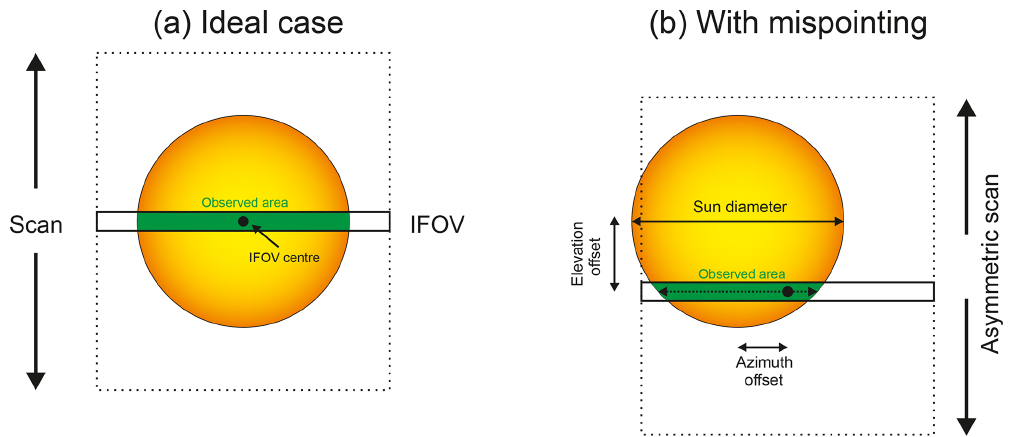
Figure 2. SCIAMACHY instantaneous field of view (IFOV) while scanning over the Sun. (a) Ideal case (Sun in centre of IFOV). (b) With mispointing (shift between centres of Sun and IFOV); this is actually the nominal case.